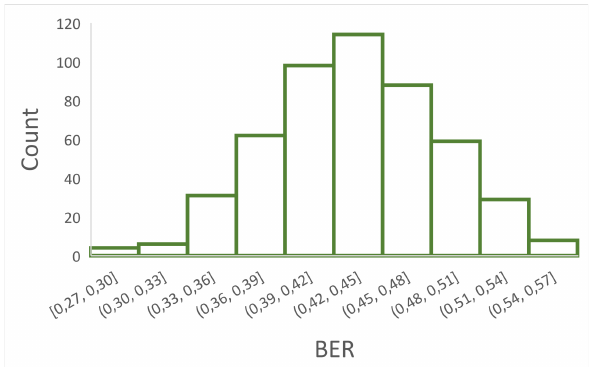
Figure 3. Gaussian distribution of 499 BER (bit error rate) values: An